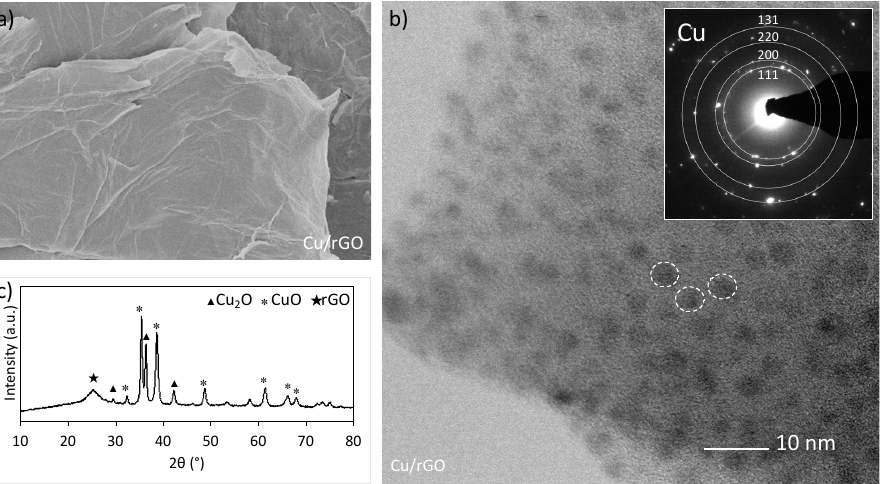
Figure 3. SEM ( a ) and TEM with SAED of CuNPs ( b ) of Cu/rGO used for synthesis of H1/G(Cu) composites. The XRD pattern of Cu/rGO after heating at 120 °C/2 h in DMF and air ( c ).